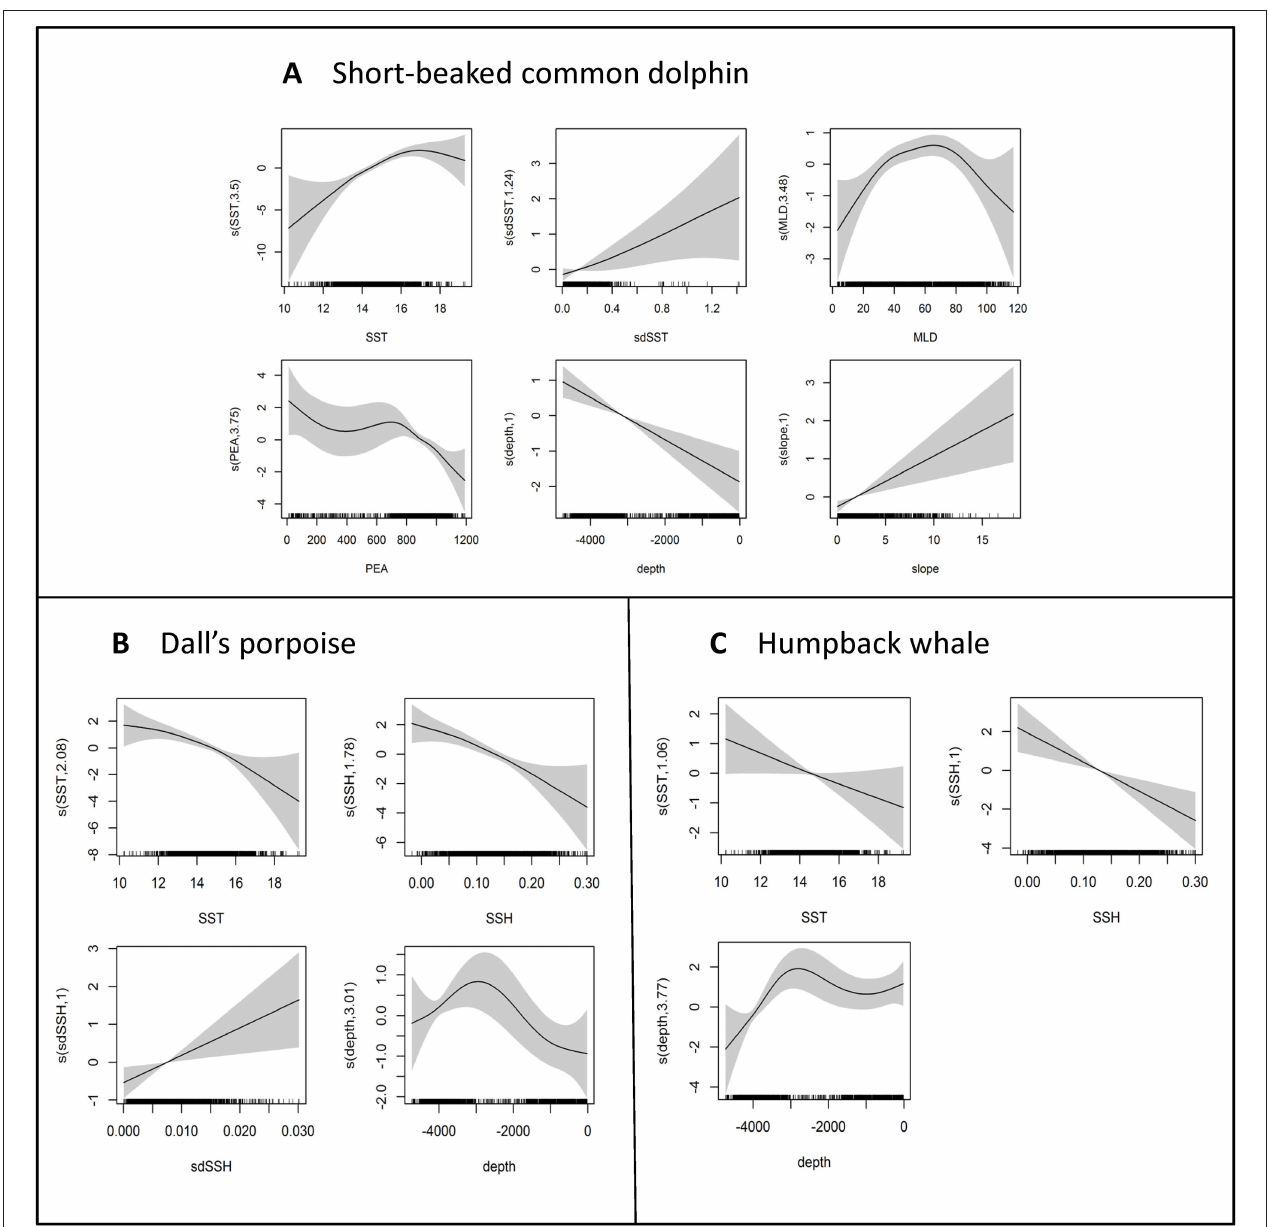
FIGURE 3 | Functional forms for variables included in the final encounter rate (short-beaked common dolphin) or single response (Dall’s porpoise and humpback whale) models for (A) short-beaked common dolphin, (B) Dall’s porpoise, and (C) humpback whale. Predictor variables in the final models included: SST, sea surface temperature; sdSST, standard deviation of SST; MLD, mixed layer depth; PEA, potential energy anomaly; SSH, sea surface height; sdSSH, standard deviation of SSH; depth, bathymetric depth; and slope, bathymetric slope. The y-axes represent the term’s (linear or spline) function, with the degrees of freedom shown in parentheses on the y-axis (linear terms are represented by a single degree of freedom). Zero on the y-axes corresponds to no effect of the predictor variable on the estimated response variable. Scaling of y-axis varies among predictor variables to emphasize model fit. The shading reflects 2 × standard error bands (i.e., 95% confidence interval); tick marks (“rug plot”) above the X-axis show data